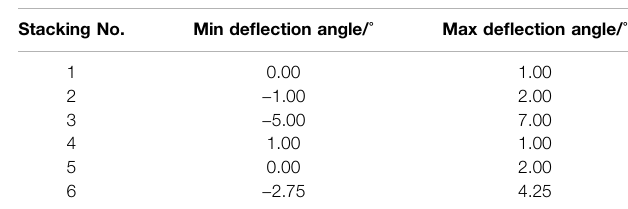
plane displacements was ignored. Data are listed in Table 3 .